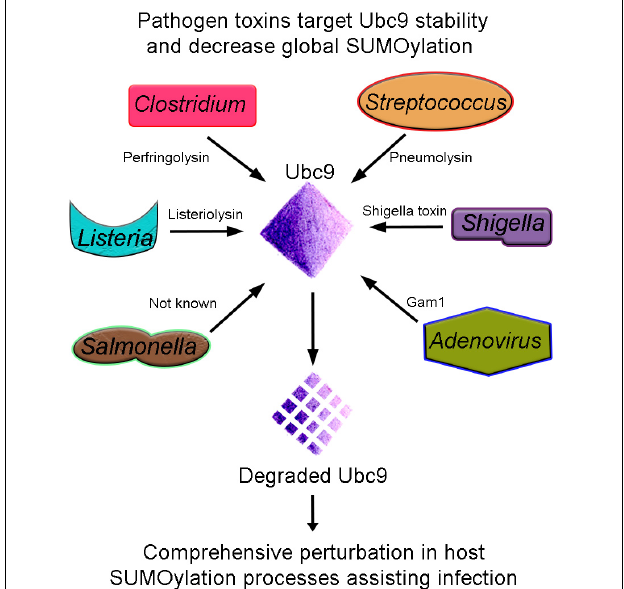
FIGURE 2 | Ubc9 degradation, an effective strategy for pathogenesis. Bacterial ( Listeria , Clostridium , Streptococcus , Shigella, and Salmonella ) and Adenovirus pathogens produce toxins that target the host conjugating enzyme Ubc9. Unstable Ubc9 adversely affects the SUMOylation dynamics, and consequently, several vital cellular processes are compromised and assist in infection.